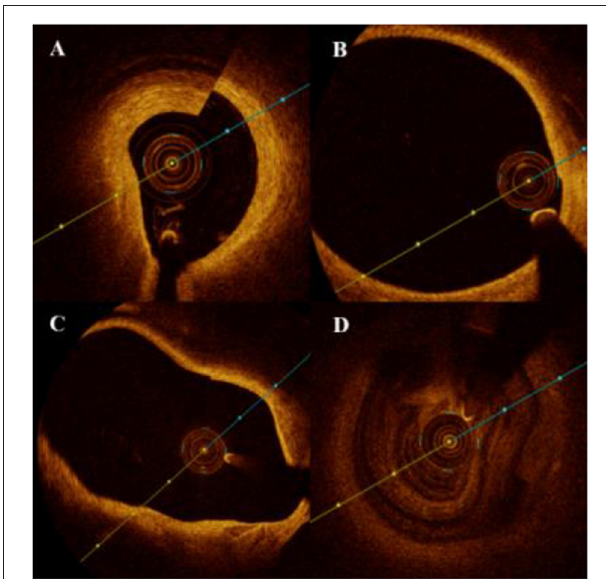
FIGURE 1 | Artifacts of optic coherence tomography for the detection of intracranial atherosclerotic stenosis (ICAS). (A) Rotational artifact appears as an apparent misalignment of the luminal border due to rapid axial rotation of the imaging catheter during pullback. (B) Decentration artifact appears as the distortion and/or invisible part of image because of the eccentric position of frequency-domain optical coherence tomography (FD-OCT) catheter. (C) Caliber artifact was defined as the integrity loss of the whole lumen due to the large diameter of the vessel, and (D) blood-flow artifact was defined as light dissipation caused by the residual blood due to inadequate replacement.